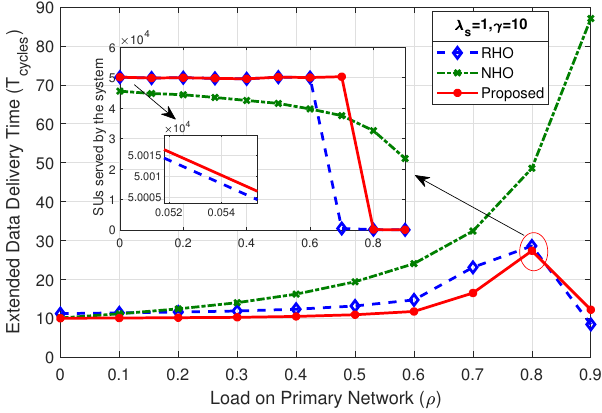
Figure 10. Comparison of mean EDDT for λ s = 1, γ = 10.